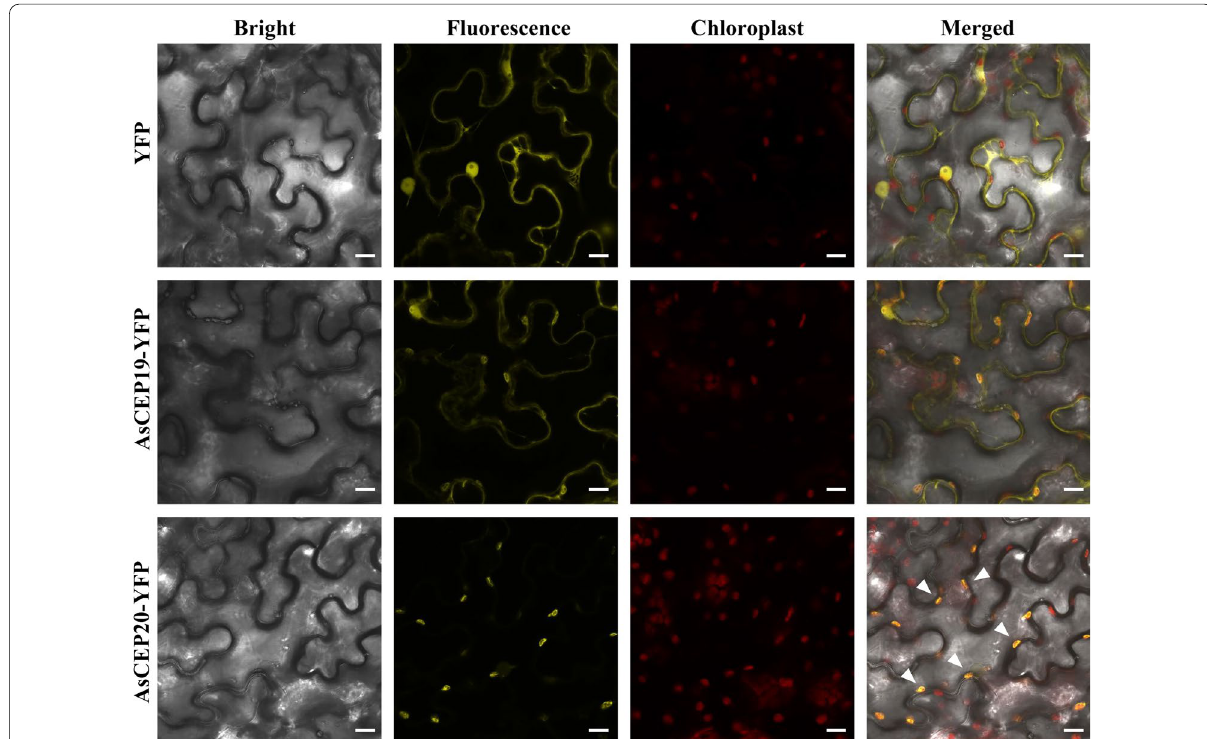
Fig. 7 Subcellular localization of AsCEP19 and AsCEP20 in N. benthamiana leaves. N. benthamiana leaves were infiltrated with A. tumefaciens GV3101 carrying AsCEP19-YFP, AsCEP20-YFP, or YFP plasmid constructs. Upper panels show the localization of free YFP as a control. The middle panels and bottom panels show the localization of AsCEP19-YFP and AsCEP20-YFP, respectively (arrows point to the chloroplasts). Bars, 10 μm